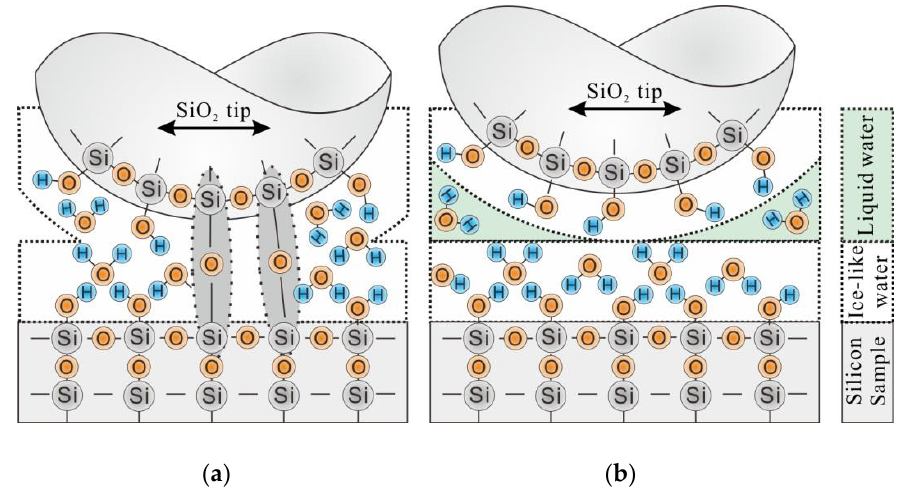
Figure 7. The illustration showing the wear mechanism of Si/SiO 2 pair at ( a ) 60% RH and ( b ) 90%